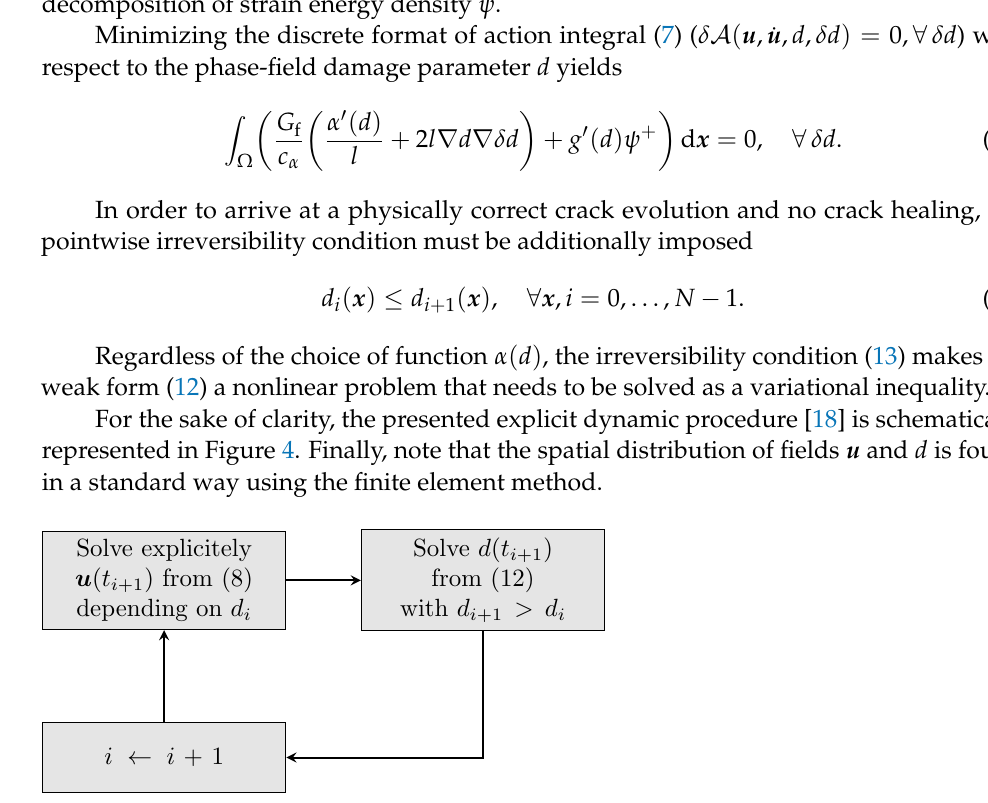
Figure 4. Flowchart of the central difference phase-field